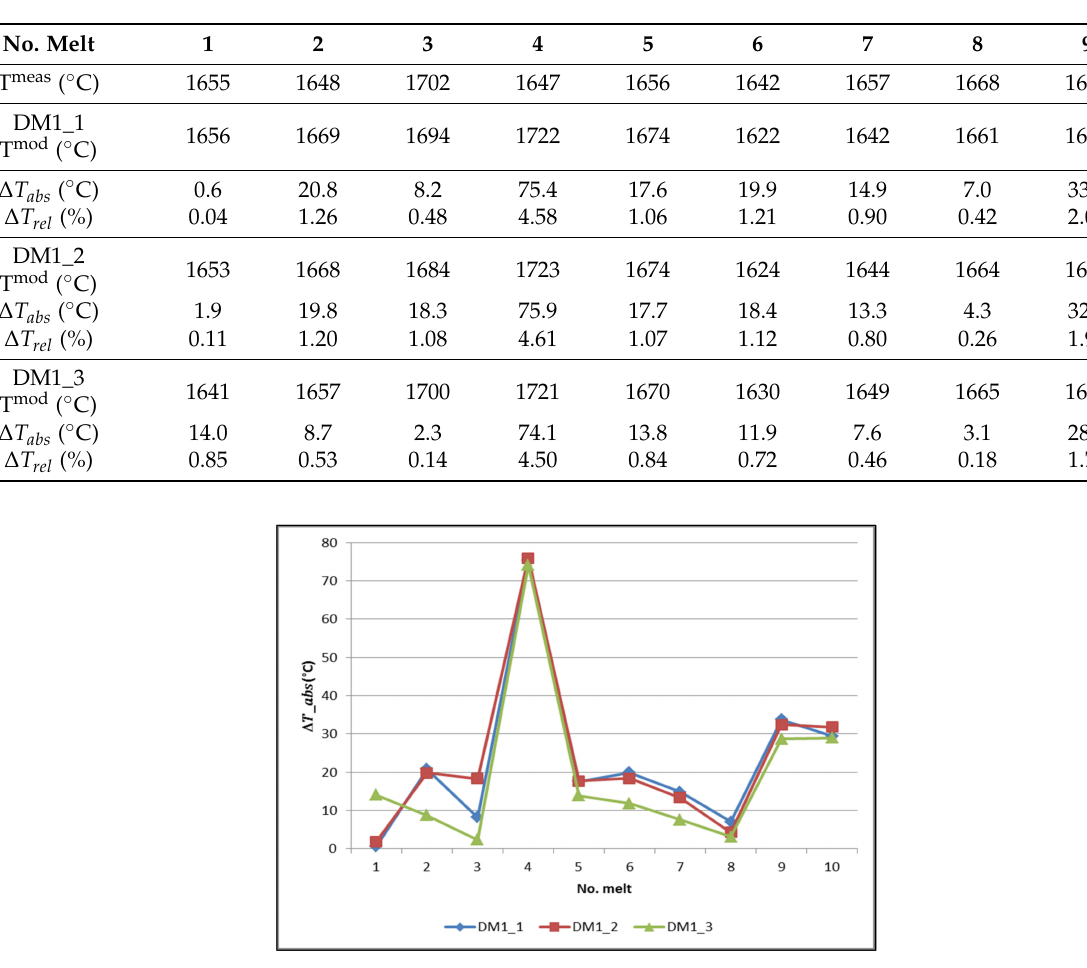
Table 2. The results of the deterministic model with feedback.